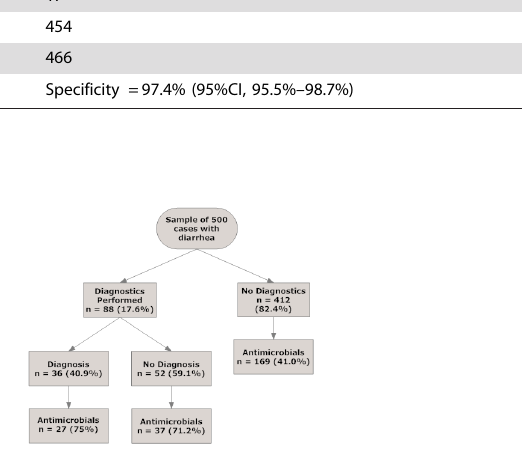
Figure 1. From a random sample of 500 companion animal cases with diarrhea, a flow diagram describing the proportion of cases that had laboratory diagnostics performed, had an etiological diagnosis made, and were administered, prescribed or dispensed antimicrobials.